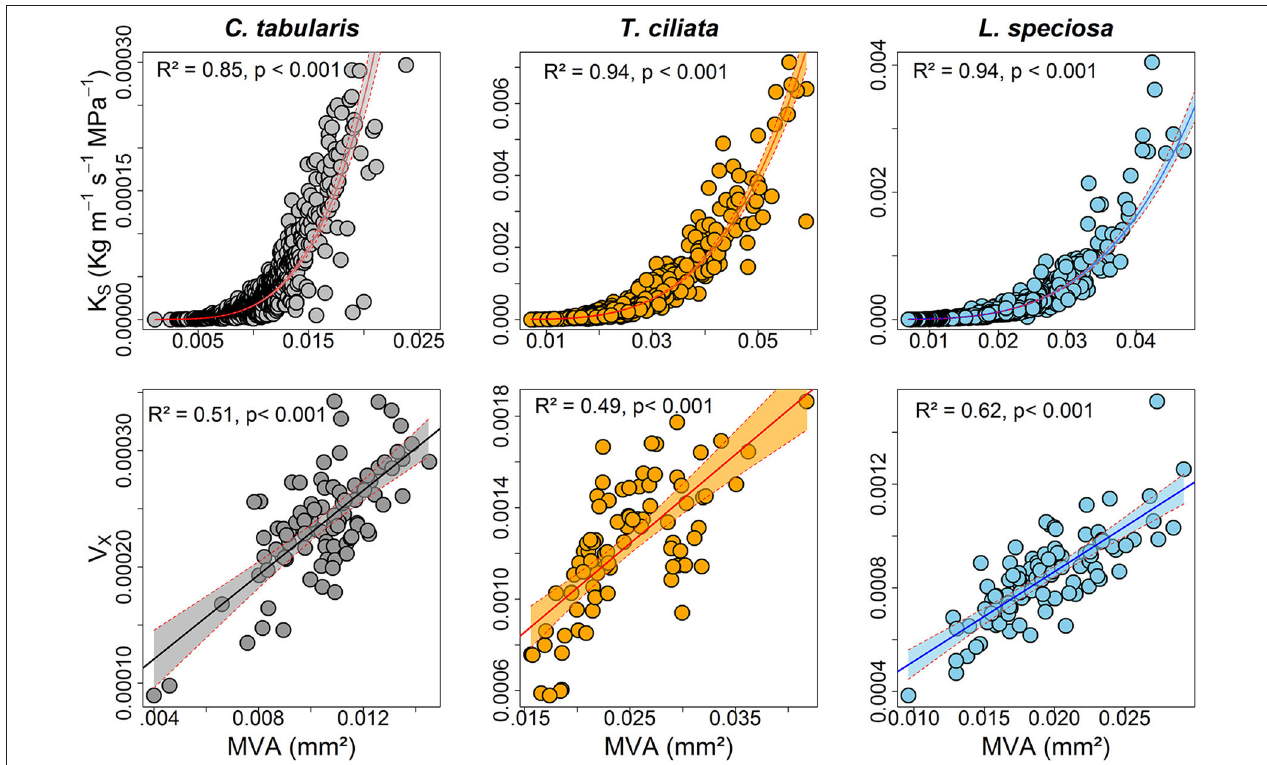
FIGURE 8 | Relationships between hydraulic traits and vessel size (mm 2 ) of three South Asian tropical forest tree species. Shaded areas represent 95% confidence intervals.